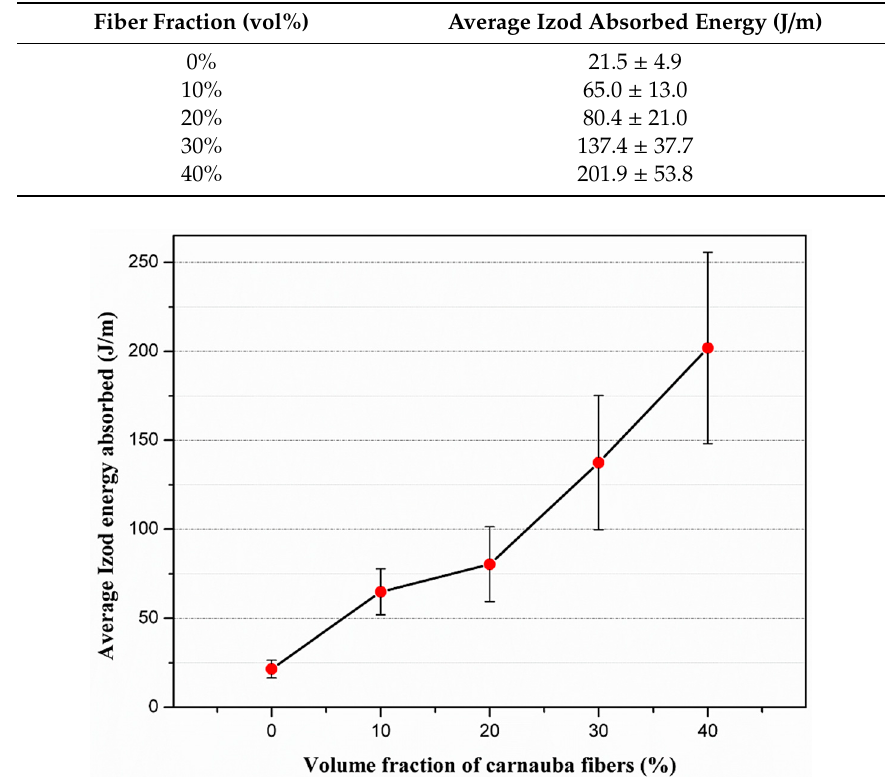
Table 3. Results of the Izod impact test for epoxy matrix composites reinforced with continuous and aligned carnauba fibers.